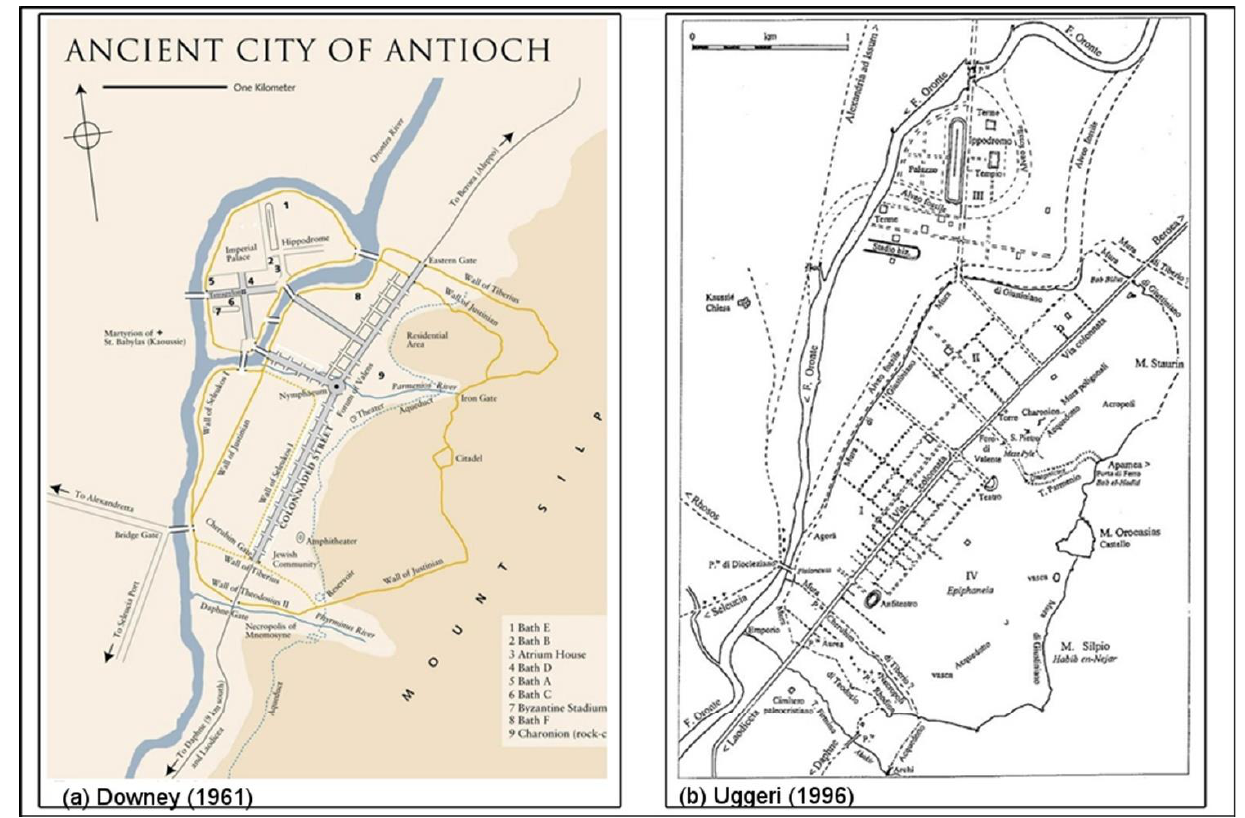
Figure 2. ( a ) Downey’s (1961) map and ( b ) Uggeri’s (1996) map of Ancient Antioch .